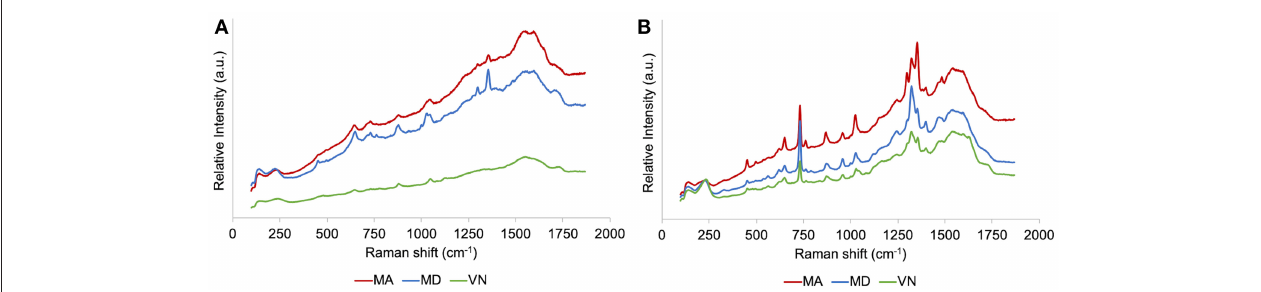
FIGURE 4 | SERS spectra for the three white wine samples acquired using a 532nm laser line. Two different protocols for sample preparation, corresponding to different incubation times, were used after mixing the AgNS colloid with the wine samples: (A) Overnight incubation, and (B) “mix-and-read” approach.